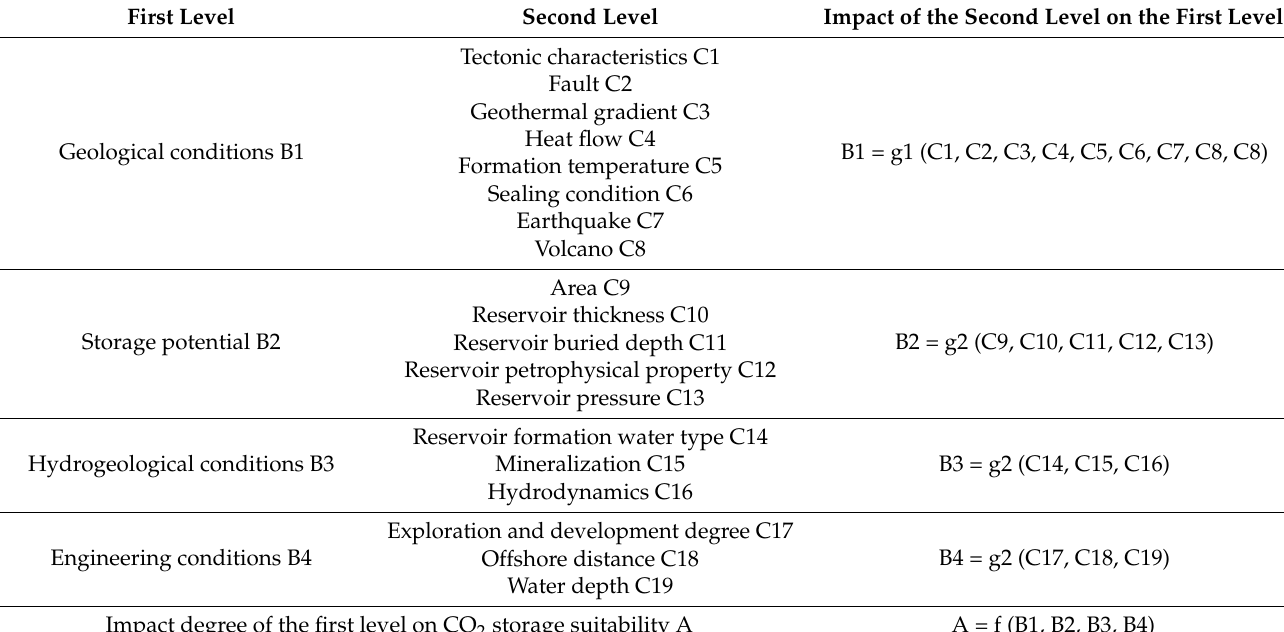
Table 3. Grading table of evaluation index